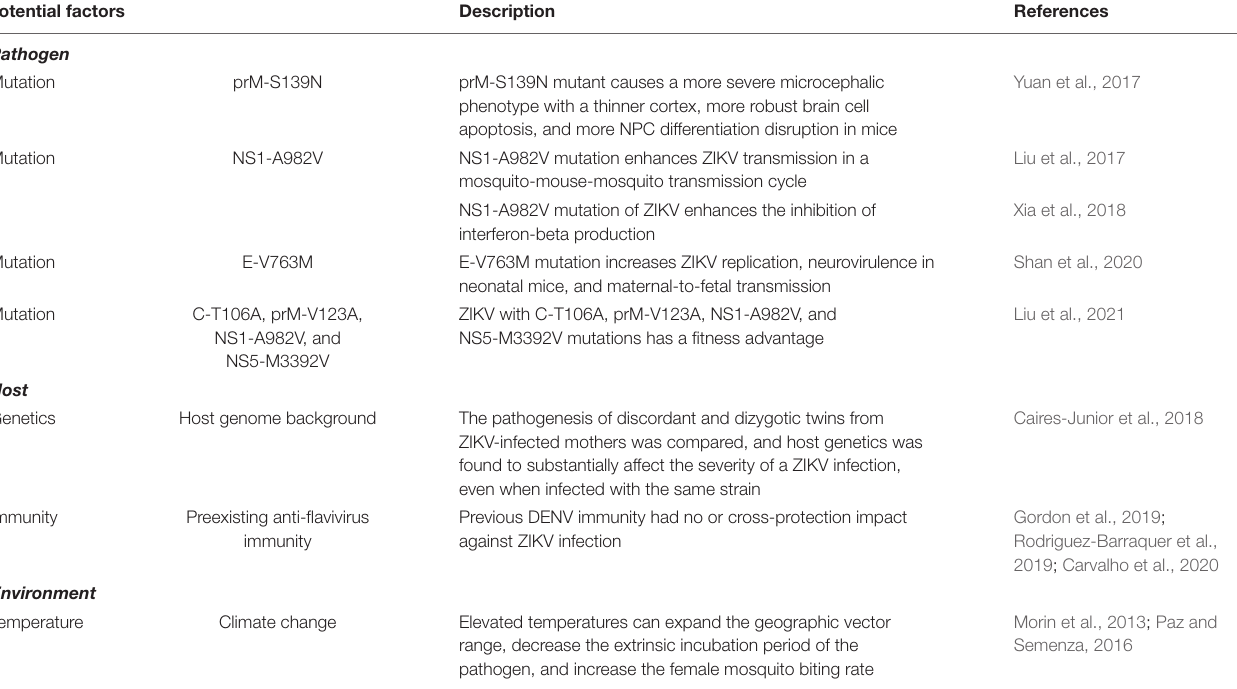
TABLE 1 | Potential factors contributing to the recent emergence of Zika virus (ZIKV).